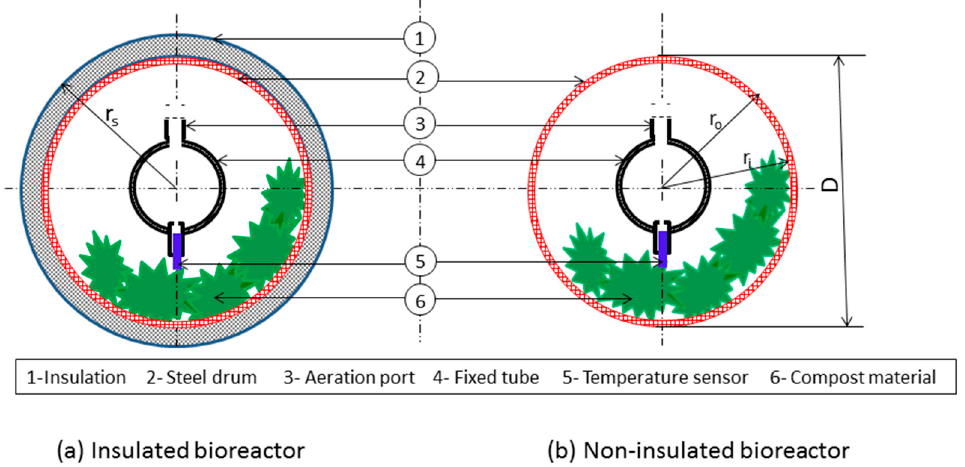
Figure 2. Cross-sectional view of ( a ) insulated and ( b ) non-insulated bioreactors.